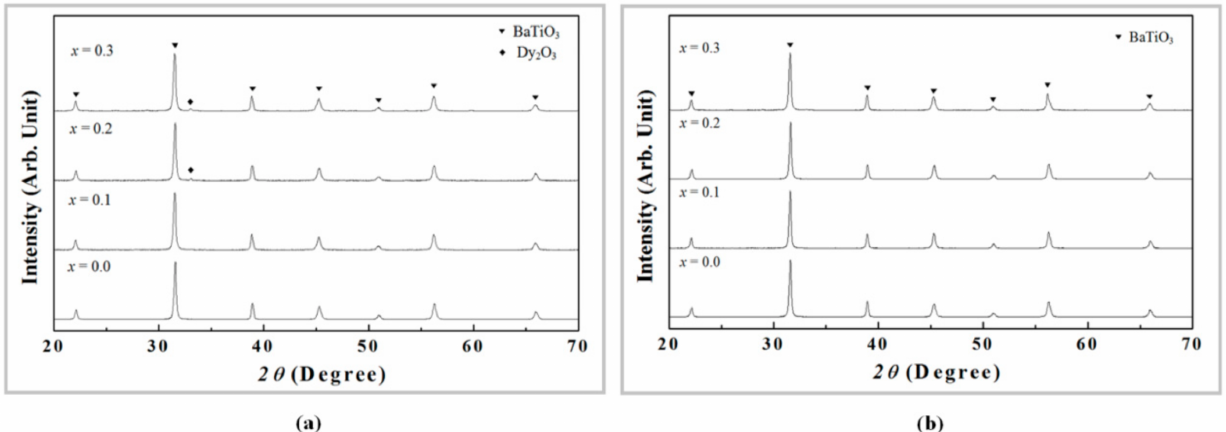
Figure 1. X-ray diffraction (XRD) patterns of the 0.98BaTiO 3 -0.02(Ba 0.5 Ca 0.5 )SiO 3 ceramics doped with x wt.% Dy 2 O 3 (0.0 ≤ x ≤ 0.3) and ( a ) sintered at 1260 ◦ C for 1 h and ( b ) 1320 ◦ C for 1 h.